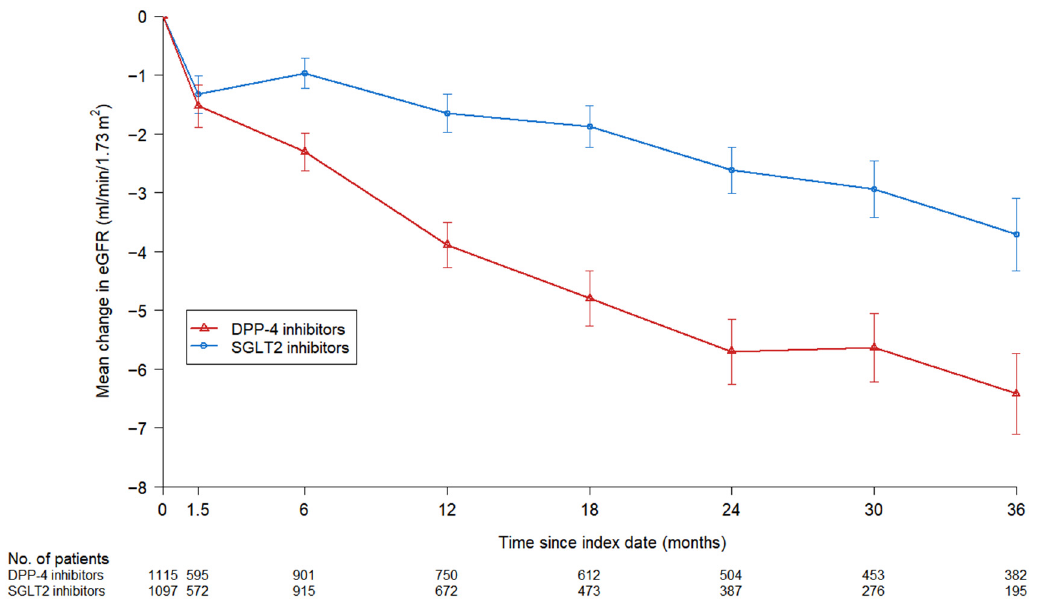
Figure 3. Change in eGFR in the SGLT2 inhibitors group and DPP-4 inhibitors group. Error bars